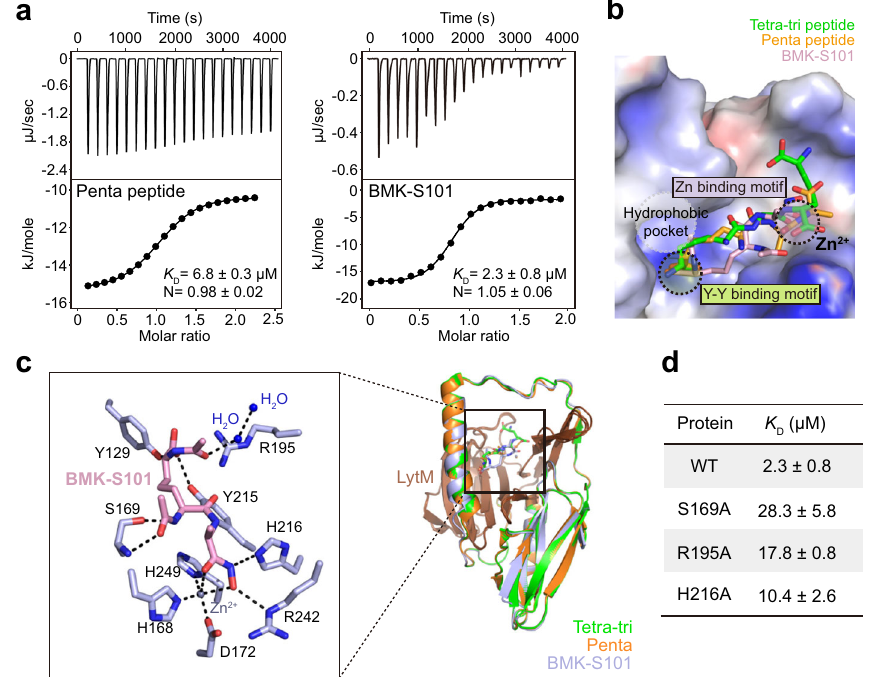
Fig. 2 Structural and functional studies on Pgp3 in complex with BMK-S101. a Representative ITC fi tting results of Pgp3 with the pentapeptide and BMK- S101. The thermodynamic data were collected from titration of compounds into Pgp3, and the parameters were calculated by fi tting to a single-binding model. Due to cleavage, Pgp3 H247A variant was used for the pentapeptide. b Surface representation of the electrostatic potential of Pgp3 in complex with the tetra-tripeptide (green), the pentapeptide (orange), and BMK-S101 (light pink). Characteristic motifs are shown with dashed circles. Substrate binding pocket (S1 ’ , S1, and S2) are colored in lime. c Superposition of three crystal structures of Pgp3 (H247A variant with the tetra-tripeptide in green, with the pentapeptide in orange, and with BMK-S101 in light pink). Detailed interaction of Pgp3 H247A active sites bound with BMK-S101 are expanded. BMK-S101 is shown in sticks colored with light pink, and key residues interacting in Pgp3 are colored with light blue. The coordination of Zn 2 + and hydrogen bonds are represented by black dashed lines. Zn 2 + ion and water molecules are shown in blue and slate gray spheres, respectively. d K D values for Pgp3 WT or variants with BMK-S101. ITC fi tting results are shown in Fig. 2a and Supplementary Fig. 1b –